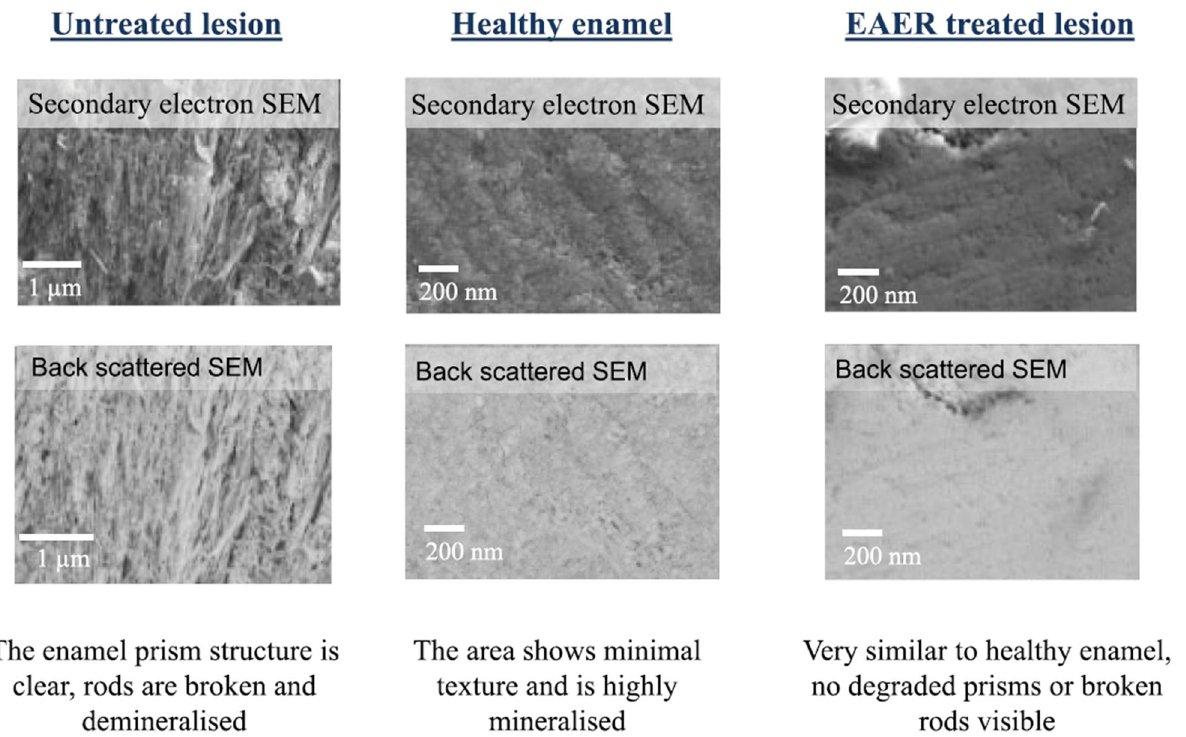
Fig. 10 SEM examinations of demineralised enamel and EAER-treated enamel. In the untreated lesions, the enamel rod structure is clear: rods are broken and demineralized. However, enamel in the EAER-treated lesions is very similar to nature enamel, with no degraded rods or broken rods visible